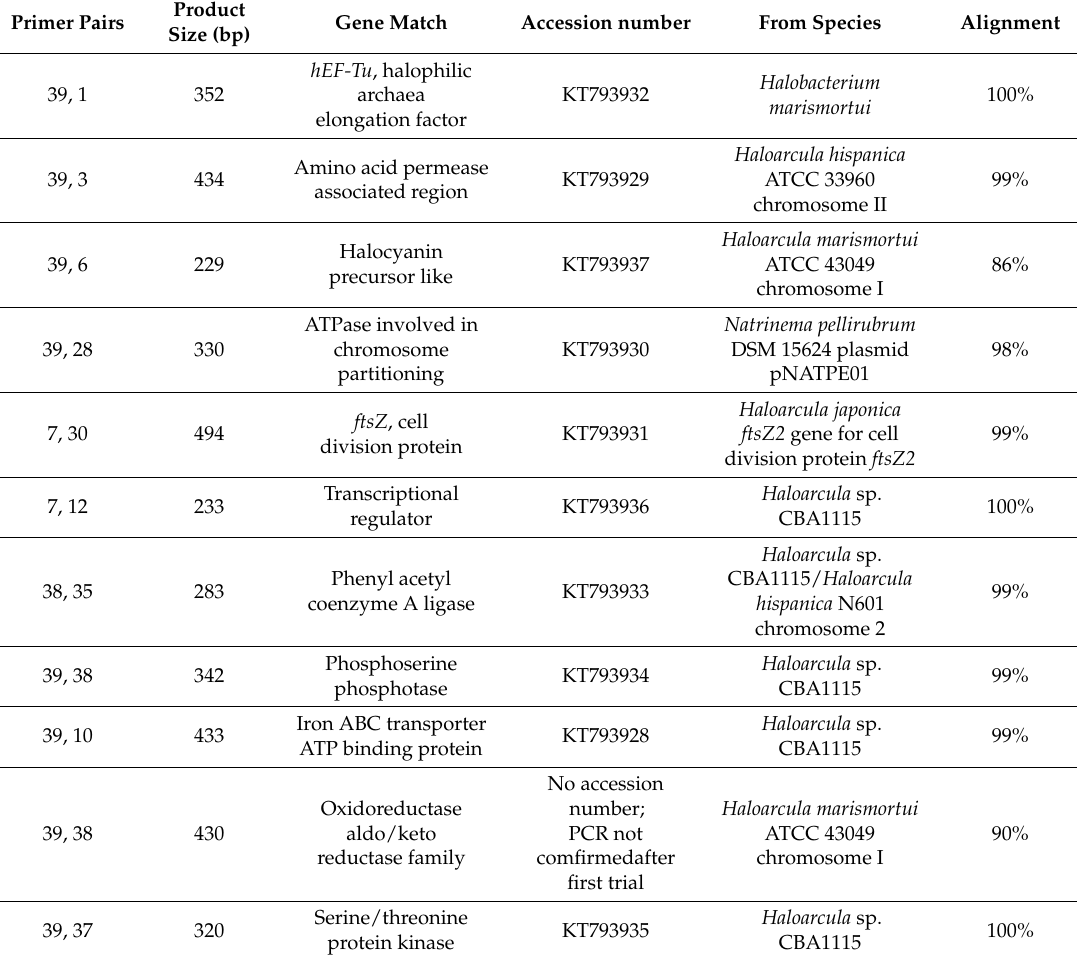
Table 3. GenBank gene sequence matches for RNA arbitrarily primed-PCR